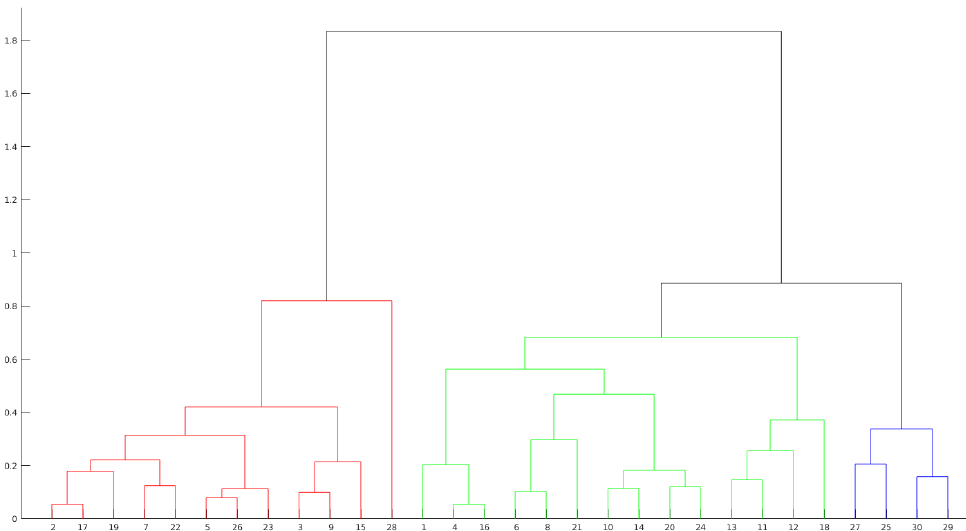
Figure 8. Dendrogram representation of presentation 3 in year